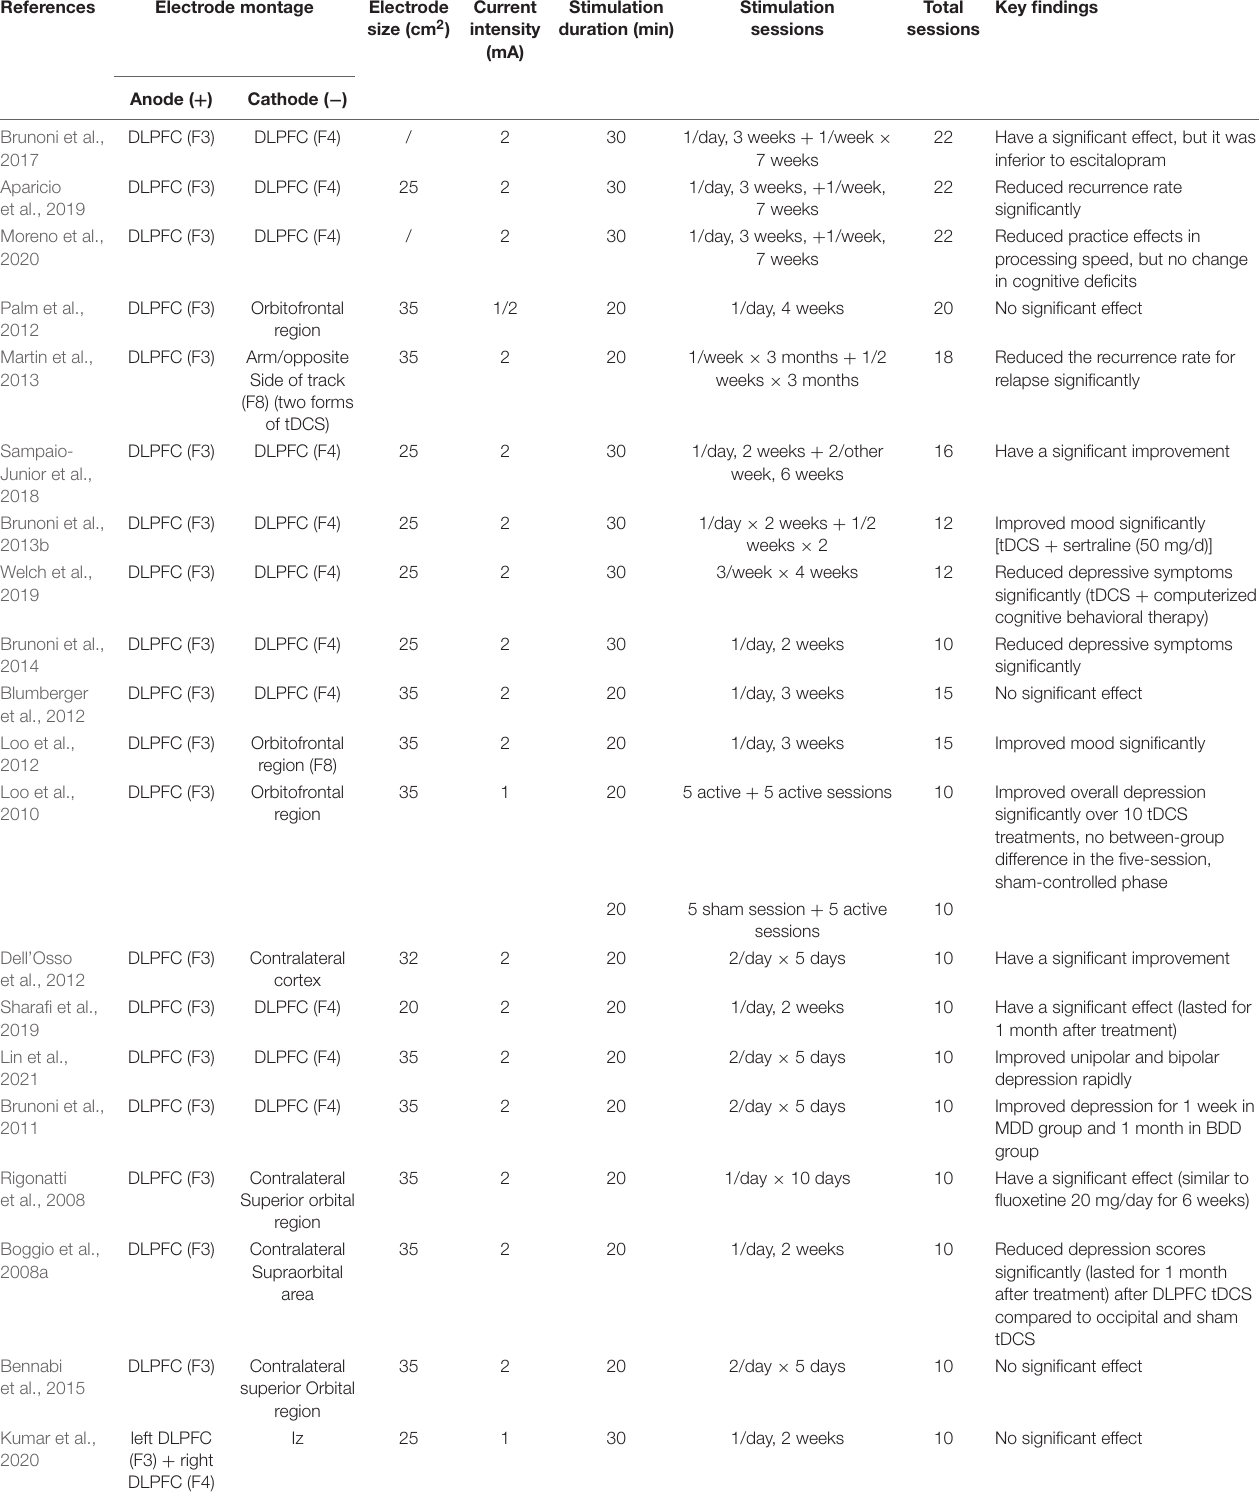
TABLE 1 | Effects of DLPFC tDCS on